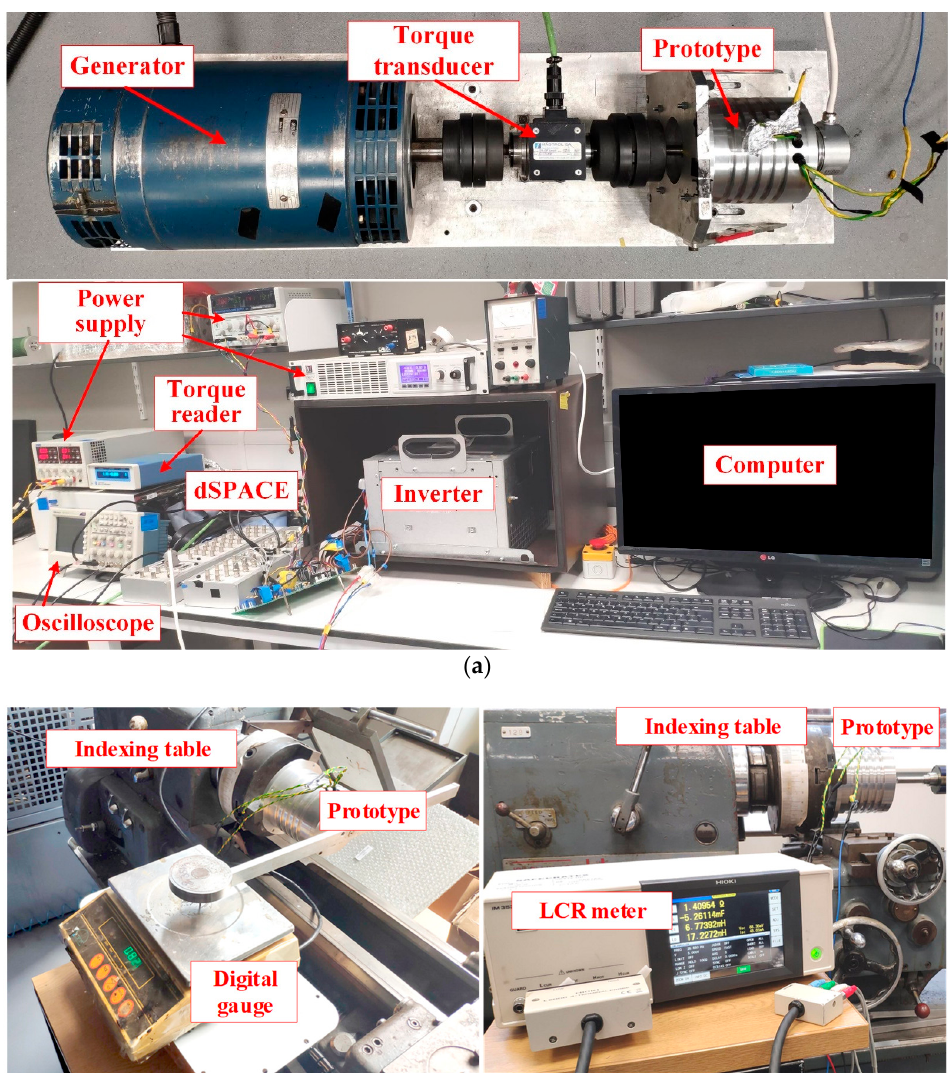
Figure 37. Manufactured prototypes. ( a ) 12s8p (left) and 12s10p (right) stators. ( b ) Rotors (from left to right: 12s8p-CCPPM, 12s8p-PSCPPM, 12s10p-CCPPM, 12s10p-PSCPPM).